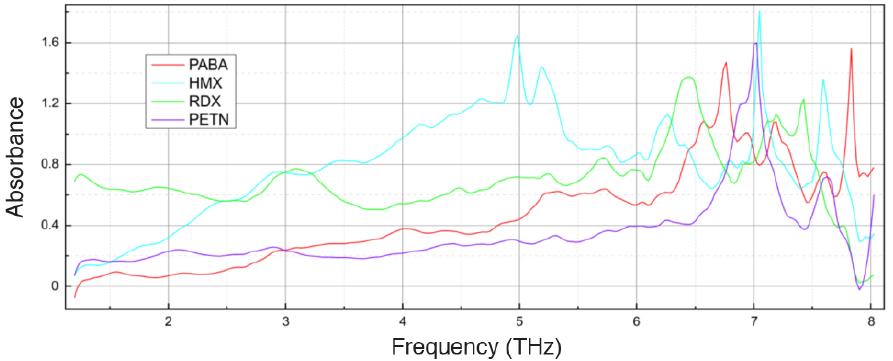
Figure 16. THz absorption spectra of a reference material PABA (para-aminobenzoic acid) and several explosives (HMX, RDX, PETN) measured with a DSTMS-based THz-TDS system [215]. Copyright 2014 Society of Photo Optical Instrumentation Engineers